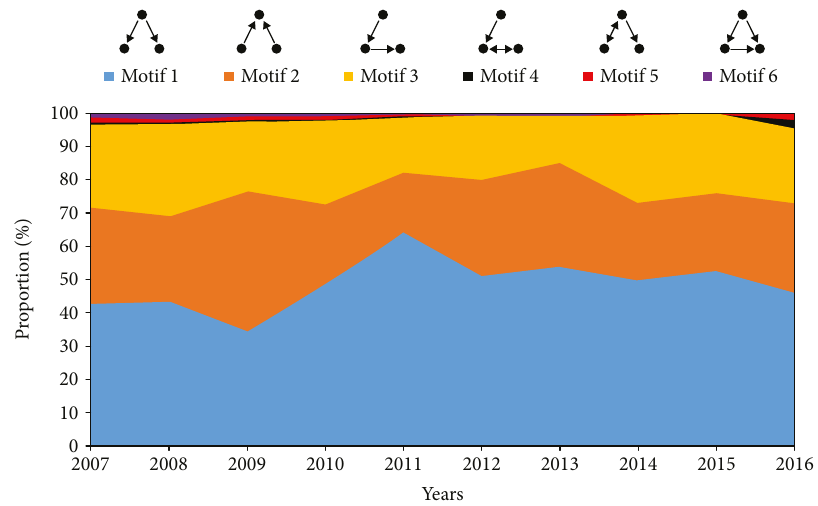
Figure 3: The evolution of the distribution of motifs in CSNs.